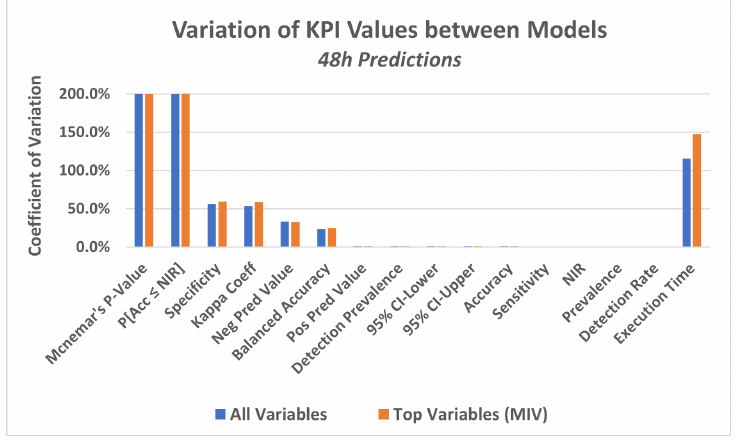
Figure 15. Variation in KPI Values between Models expressed by CV—48 h